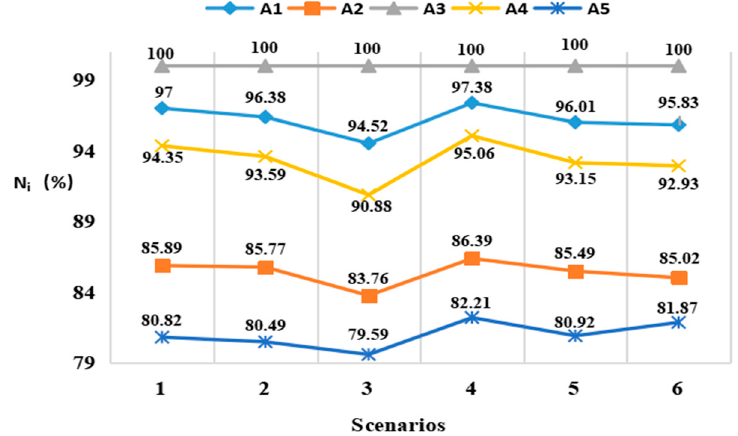
Figure 3. Sensitivity analysis of rankings by N i